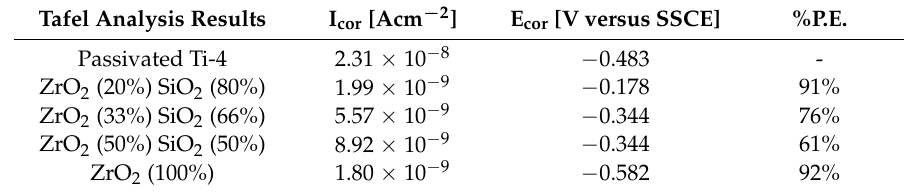
Table 3. Corrosion currents (I cor ) and corrosion potentials (E cor ), calculated via Tafel analysis on the potentiodynamic plots of the different samples and their corresponding protection efficiency (%P.E.).